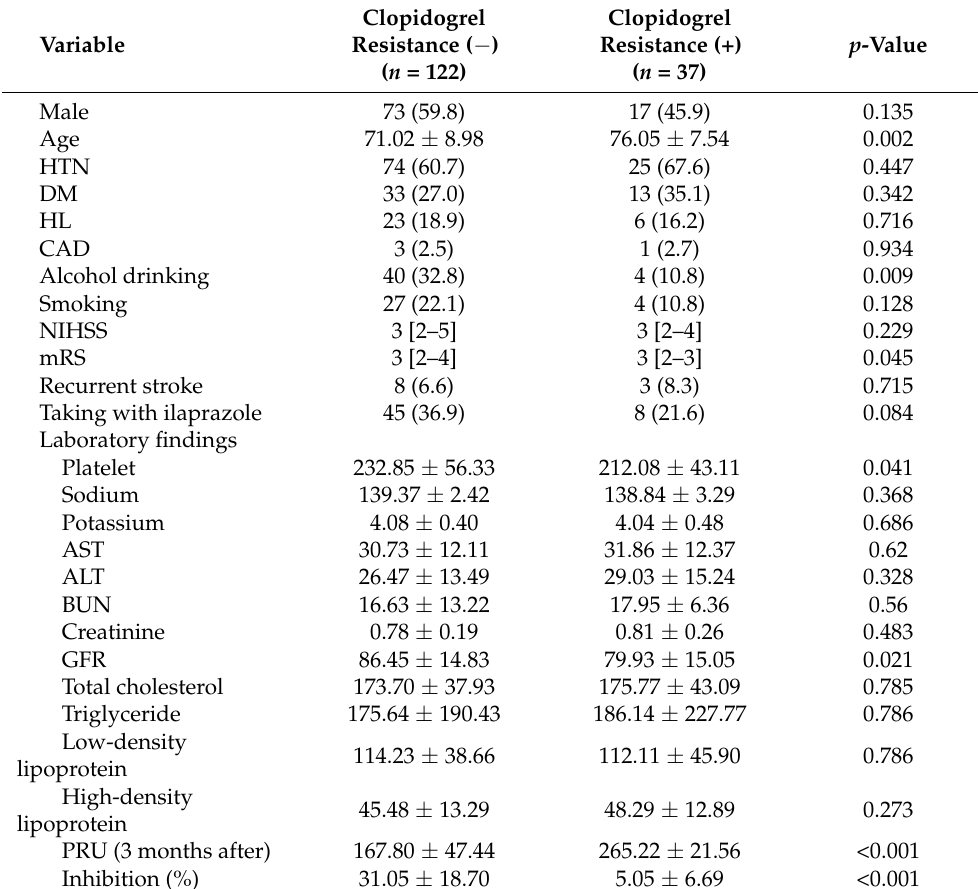
Table 1. Comparison of baseline characteristics between patients with clopidogrel resistance versus patients without clopidogrel resistance.